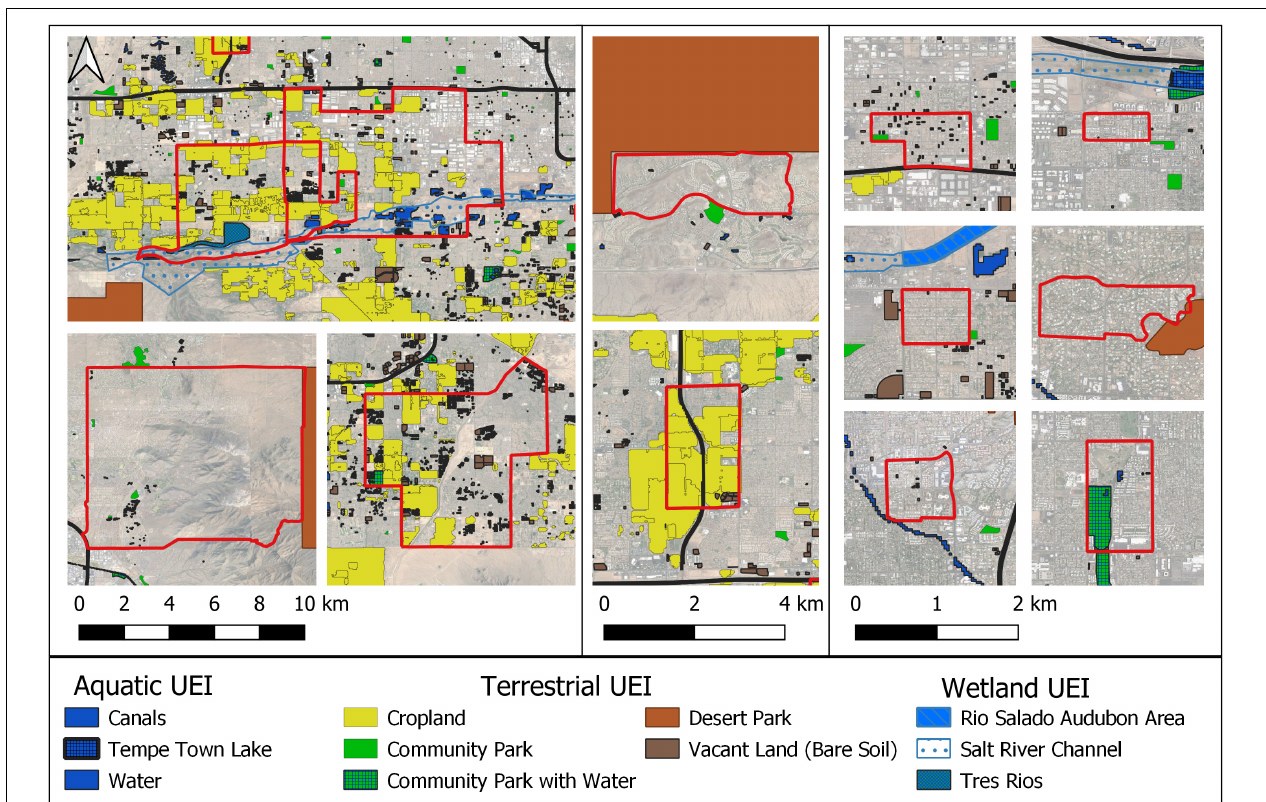
FIGURE 2 | Close ups of the various PASS neighborhoods from the study area. PASS neighborhoods outlined in red. Aquatic, terrestrial, and wetland UEI are shown throughout the study area. Base maps are from Google Earth